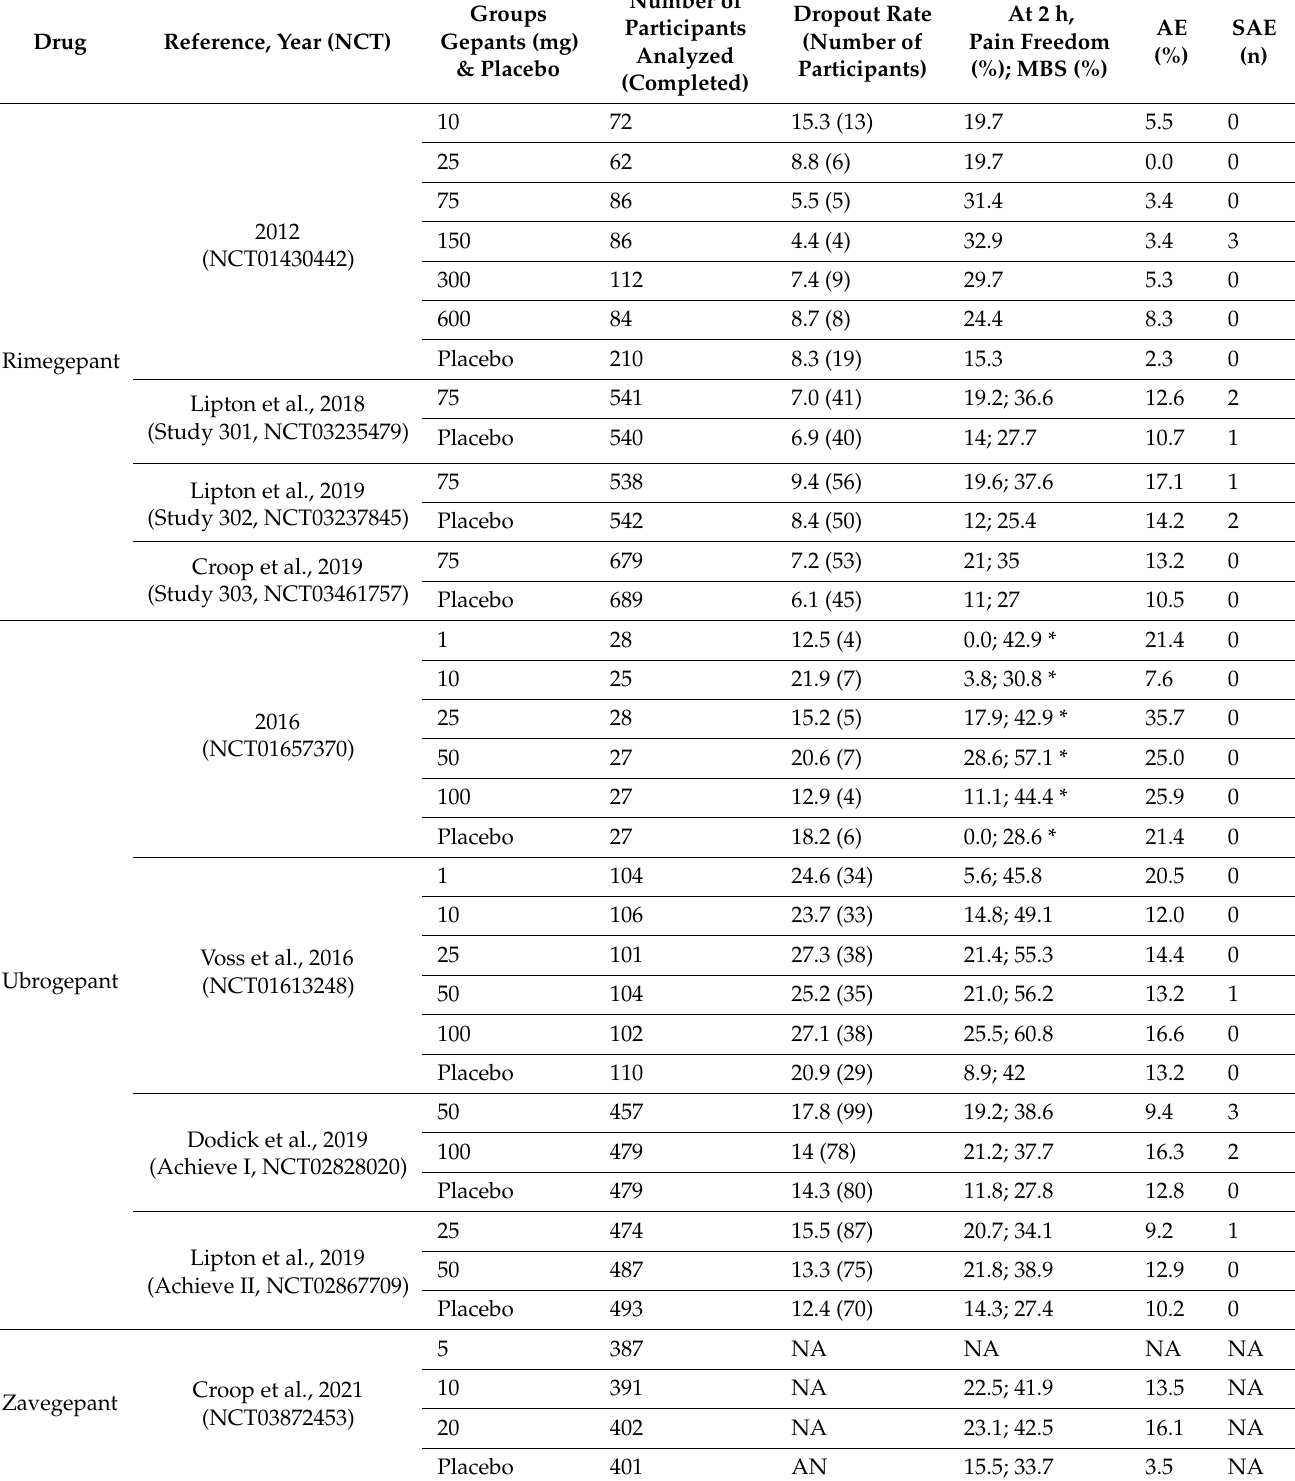
Table 2. Clinical trials of gepants indicated for acute migraine